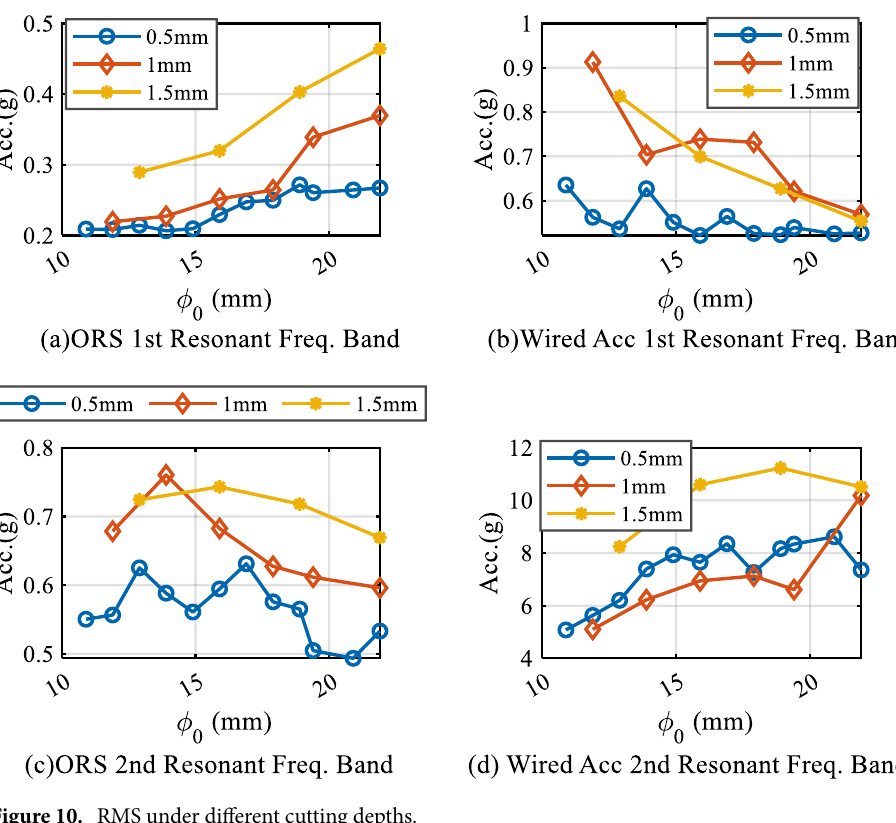
Figure 10. RMS under different cutting